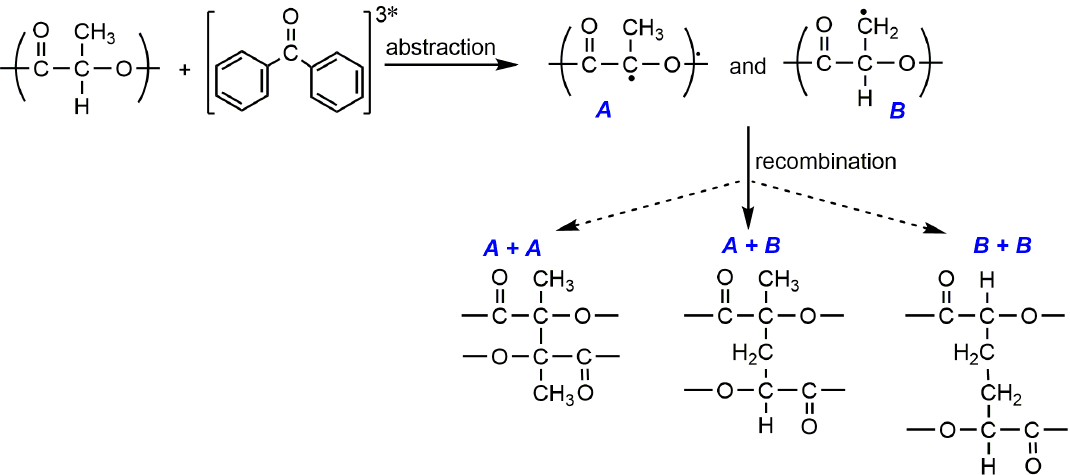
Figure 3. The proposed mechanism of photo-crosslinking of not functionalized PLA in the presence of benzophenone [78]. (Reproduced with permission from Wiley, 2013).